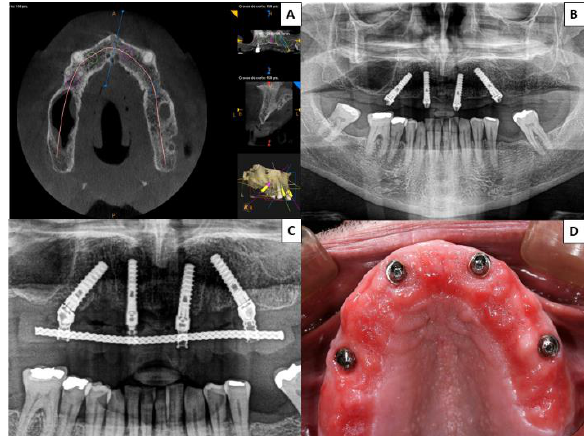
Figure 3. Group 2 patient rehabilitated with four conventional implants in the premaxilla following the all-on-four concept; two placed axially and the other two angled between 35° and 45°. ( A ) Presurgical planning with cone-beam computed tomography (CBCT) of implant distribution. ( B , C ) Postsurgical orthopantomographs taken 6 months after surgery to ensure correct fit of definitive prosthesis. ( D ) At a follow-up check-up, a patient complained of food debris trapped beneath the fixed prosthesis; when the prosthesis was unscrewed the patient was found to present mucositis.